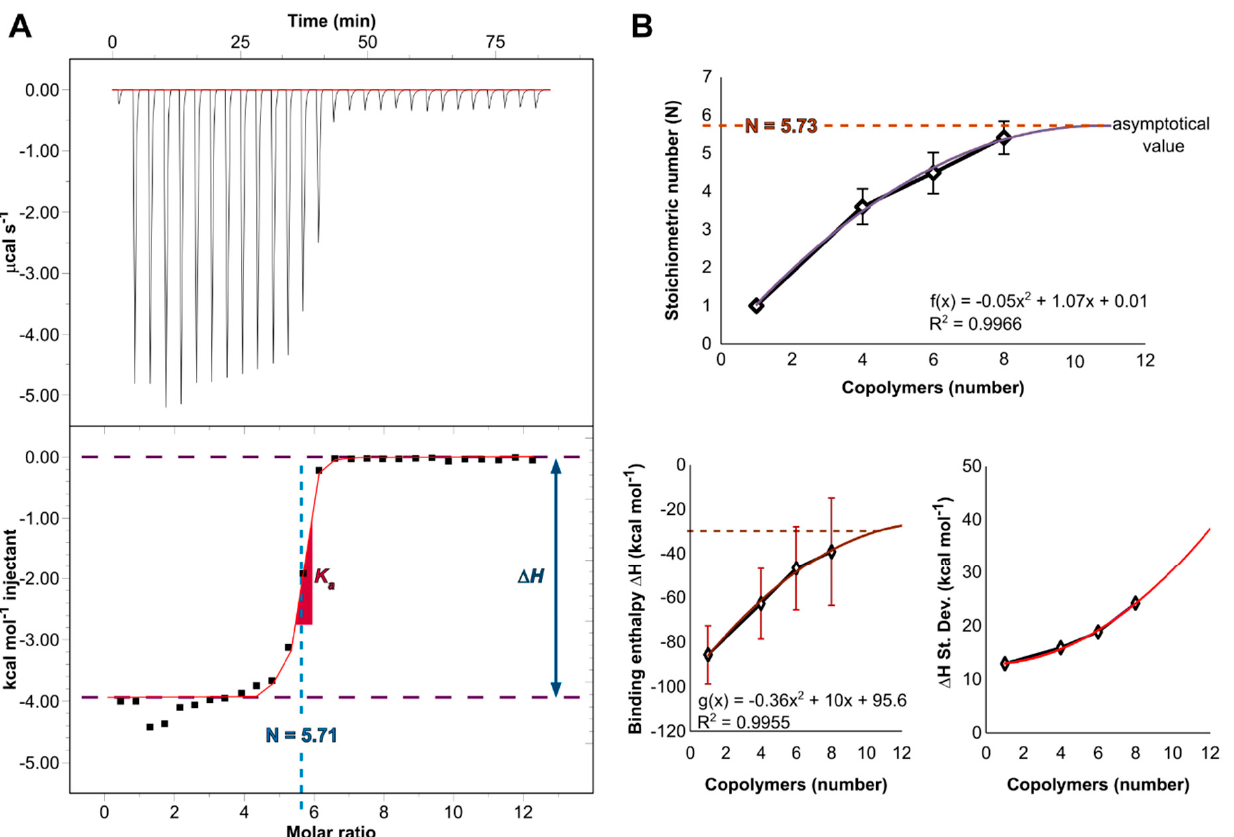
Figure 3. ( A ) ITC thermograph and titration curve-fitting by a one-site binding model ( B ) Interpo- lation curves by molecular modeling of the stoichiometry, binding enthalpy values and standard deviations following the interaction of one siRNA to multiple copolymers.